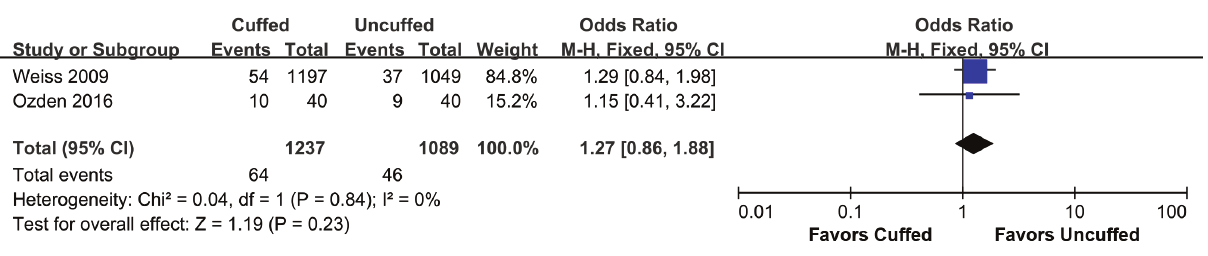
Supplemental Figure 6: The meta-analysis of stridor between cuffed and uncuffed groups.